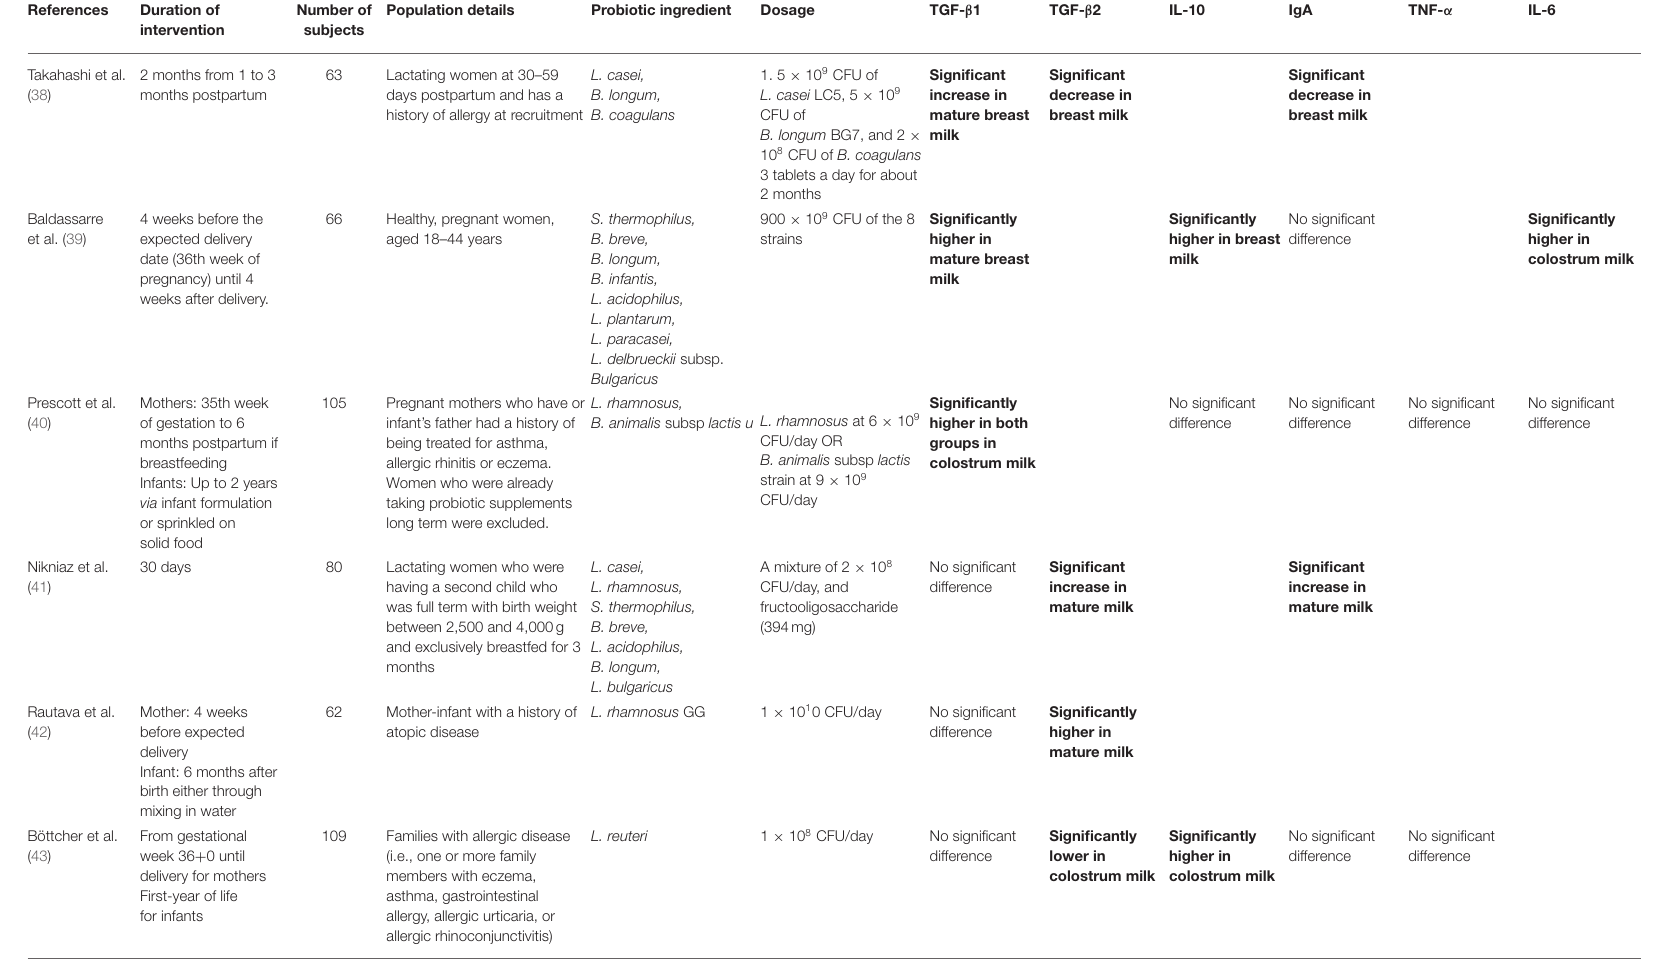
TABLE 1 | Characteristics of the study included in the